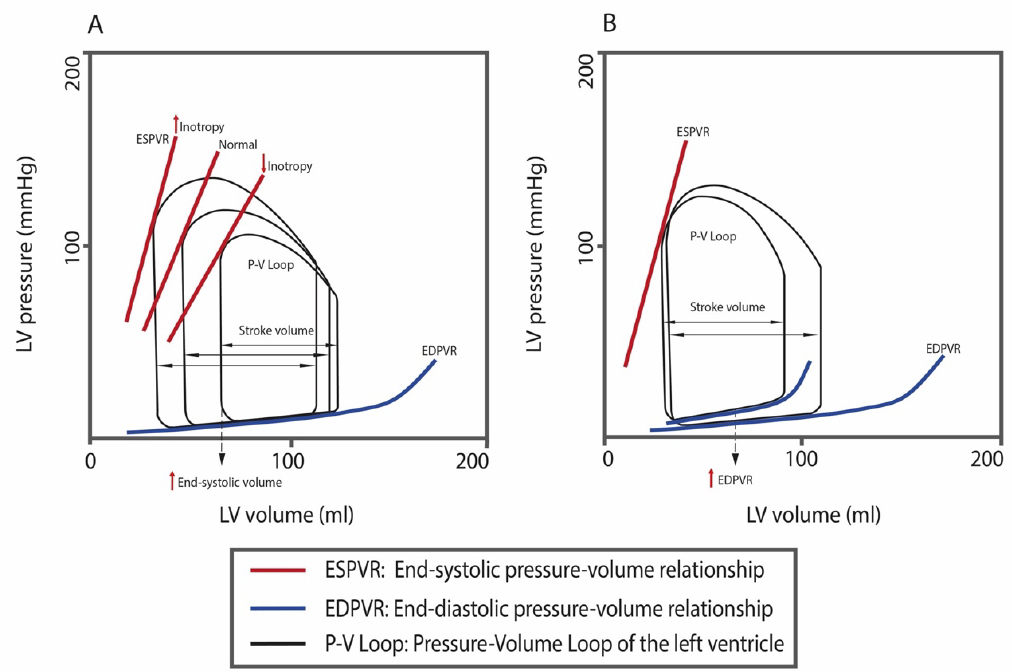
Figure 1. In panel ( A ), systolic dysfunction; in panel ( B ), diastolic dysfunction, with an ideally preserved intrinsic inotropy. Each pressure–volume loop (P–V loop) represents a heartbeat. Panel ( A ): P–V loop diagrams show changes in inotropy with a relative change in the slope of the end-systolic pressure–volume relationship (ESPVR); the decreased inotropy decreases the slope-ESPVR, shifting to the right and downwards, with impaired myocardial contractility, which generates less pressure at a given LV volume. As a consequence, the P–V loop shifts to the right and downwards, with an overall smaller loop area, and with a decrease in stroke volume, which is the width of the P–V loop (and, consequently, a lower ejection fraction), and an increase in end-systolic volume (corresponding to the left lower corner of any P–V loop). Panel ( B ): Reduced myocardial compliance increases the slope of the ventricular end-diastolic pressure–volume relationship (EDPVR), which shifts to the left. The increase in EDPVR will result in a higher filling pressure or end-diastolic pressure in the left ventricle, and a normal or reduced ventricular filling volume (decreased end-diastolic volume). A greater end-diastolic pressure leads to a greater pulmonary capillary wedge pressure. If the end-diastolic volume is decreased for the higher filling pressure, the stroke volume can also decrease per cardiac cycle.